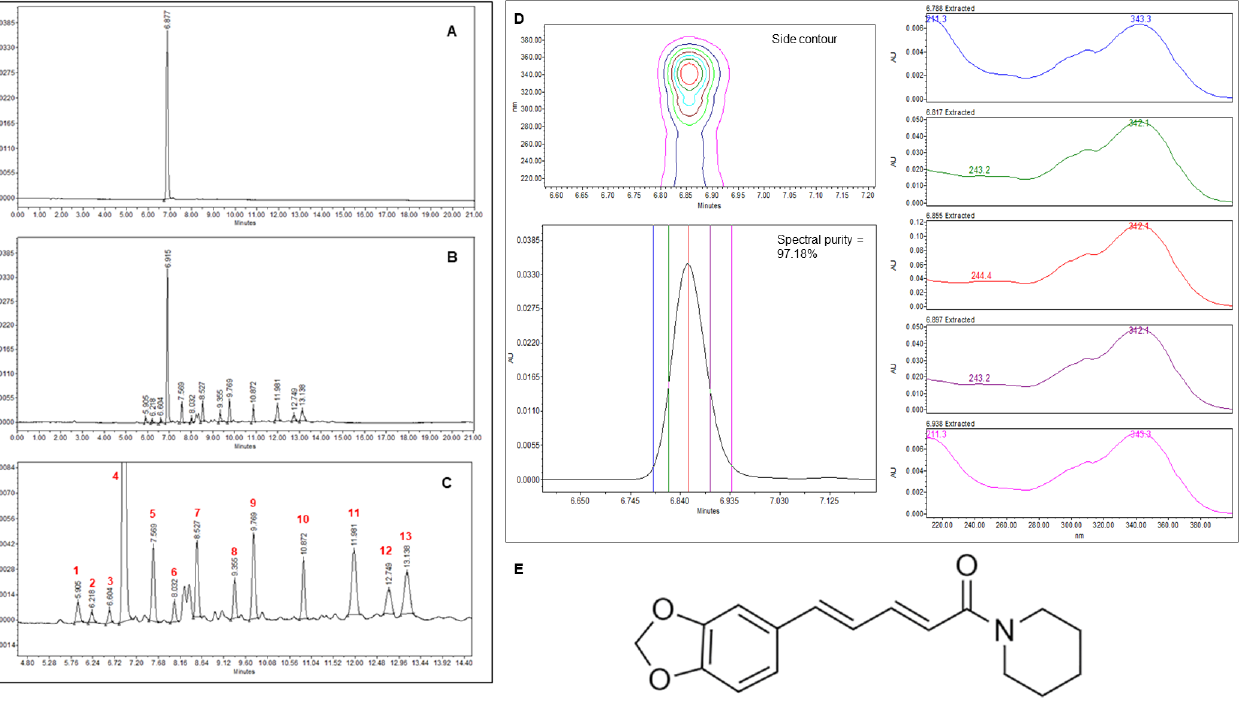
Figure 4. Validated method selectivity. ( A ). Piperine chromatographic profile (266 nm). ( B ). Chro- matographic profile of the standardized Piper nigrum ethanolic fruit extract (266 nm). ( C ). B amplified. ( D ). Spectral purity calculation for piperine standard, isolated using the average of 5 spectral peak data. ( E ). Piperine molecular